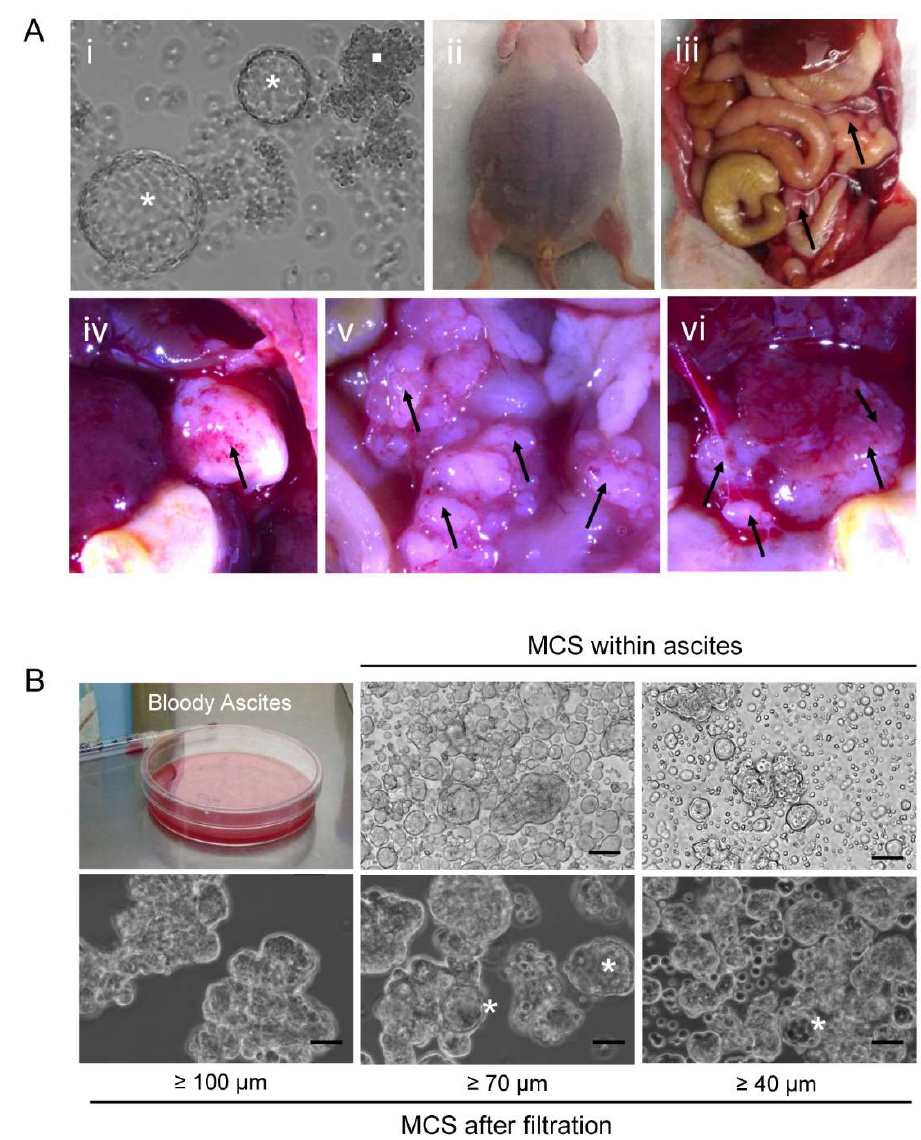
Figure 8. ( A ) Representative images depicting tumor burden in a nude mouse sacrificed after being injected in the peritoneal cavity with a mix of irregular ( square in [i]) and spheroidal ( asterisks in [i]) multicellular structures. The image in [i] was obtained using an inverted microscope. Images in [ii] and [iii] were taken with a digital camera. Images in [iv–vi] were obtained using a high-power stereoscopic microscope. Areas with arrows denote the presence of tumors, as an isolated entity [iv], in the omental area [v], and in the base of the liver [vi]. ( B ) Multicellular structures growing in the peritoneal cavity of nude mice are bloody and, upon filtration of the blood cells, show different sizes; scale bars = 25 μm.